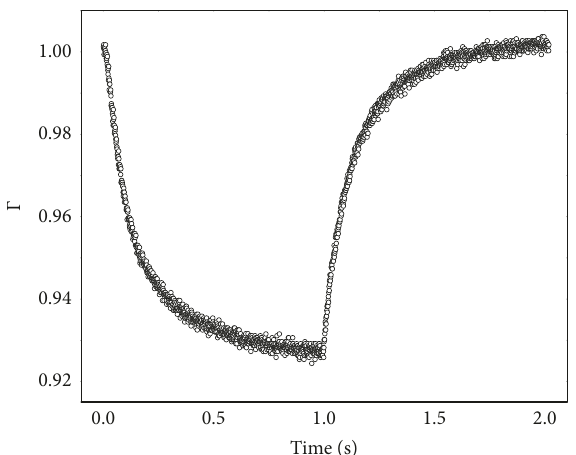
Figure 6: Typical normalized transmittance in a cycle (T = 2 s) of the shutter for a sample of the stock colloid and a pump beam of 1mW.